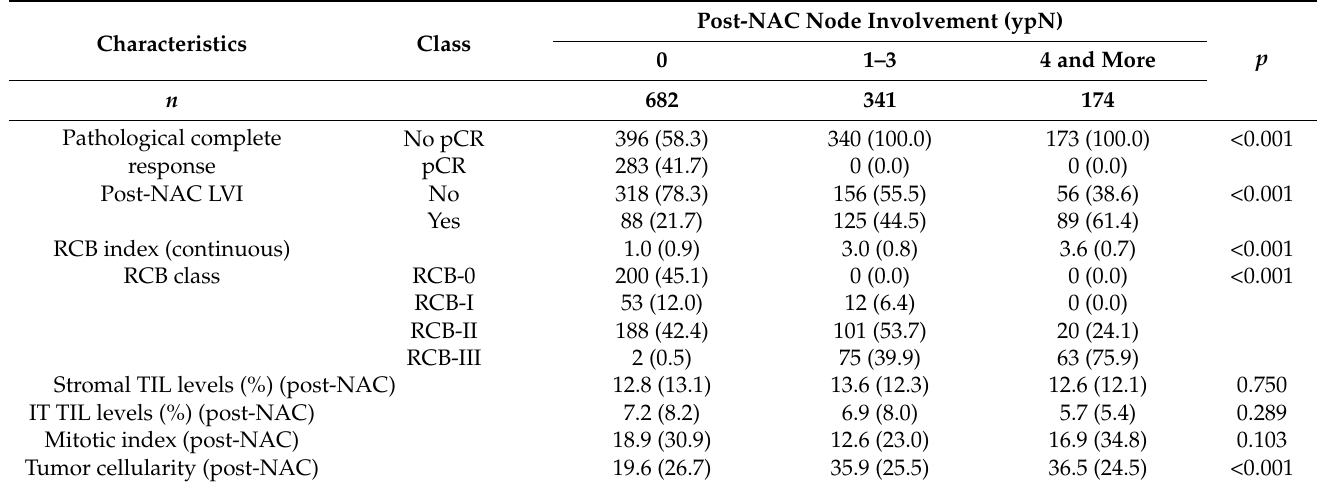
Table 2. Tumor characteristics by post-NAC nodal